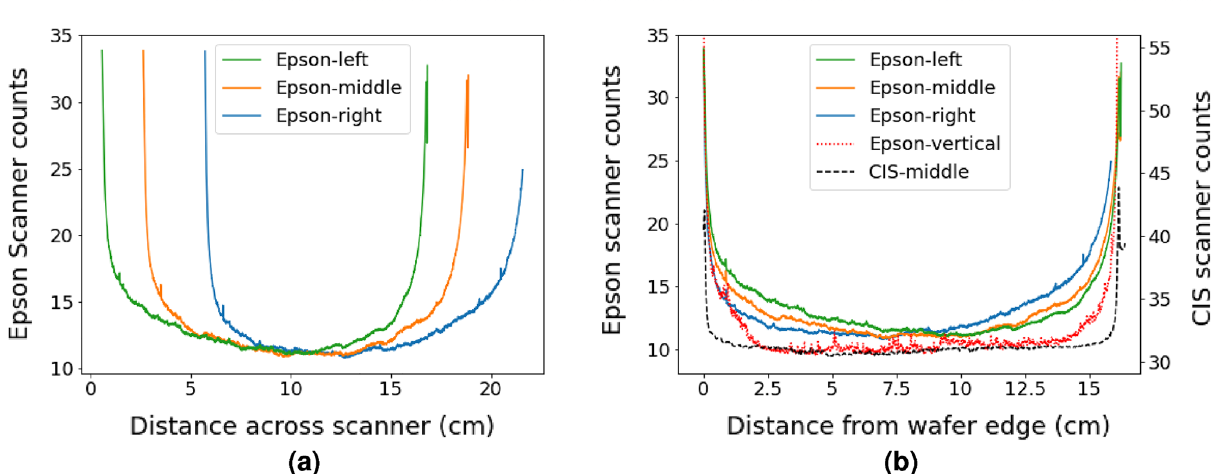
Figure 2. Repeat measurement of the same sample demonstrating the increase in the measured signal at regions away from the center of the scanner head for a CCD based Epson V800 scanner. Note the Epson V800 has a larger imaging axis compared to the Canon Lide 300, as was used to produce Fig.